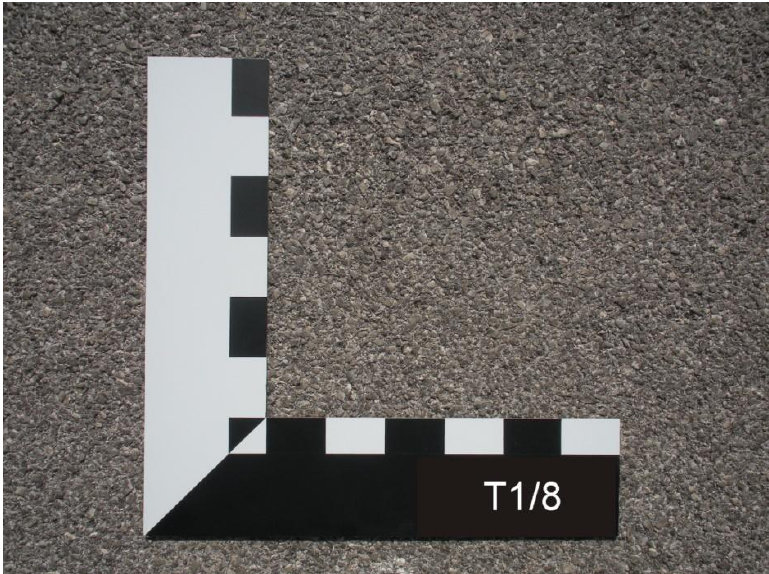
Figure 1. The 40 cm × 40 cm reference